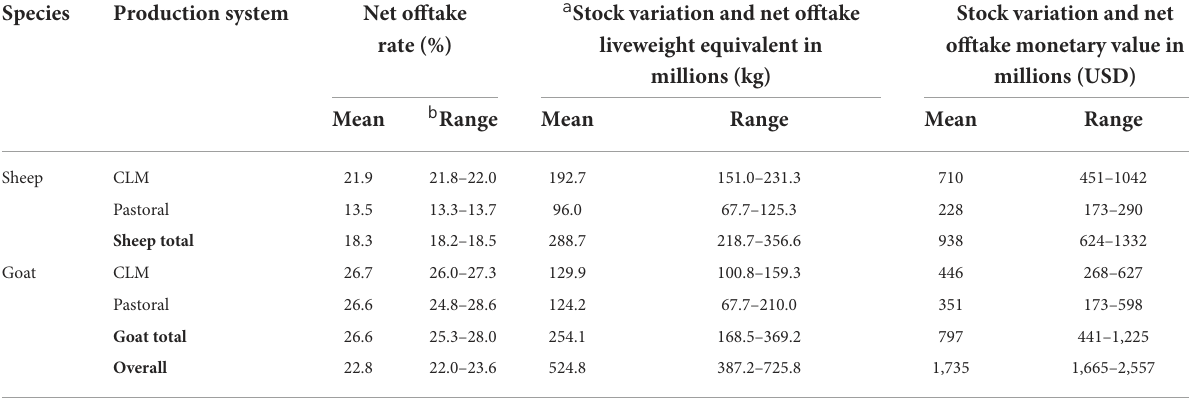
TABLE 4 Annual value of primary production (stock variation and net offtake) for year 2021. Species